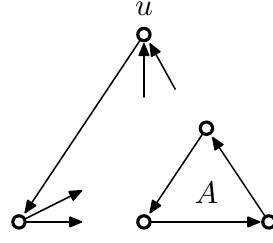
Figure 1: A tournament T with diameter 2 and rainbow connection number 3.